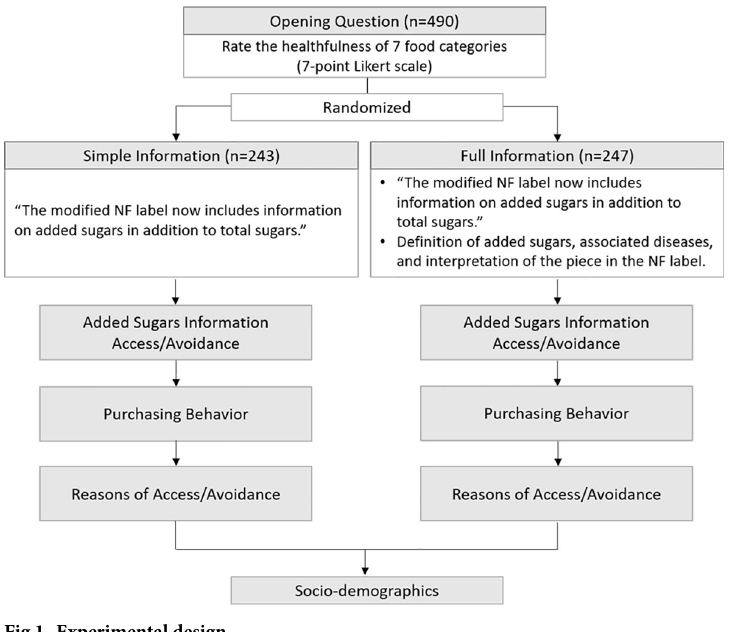
Fig 1. Experimental